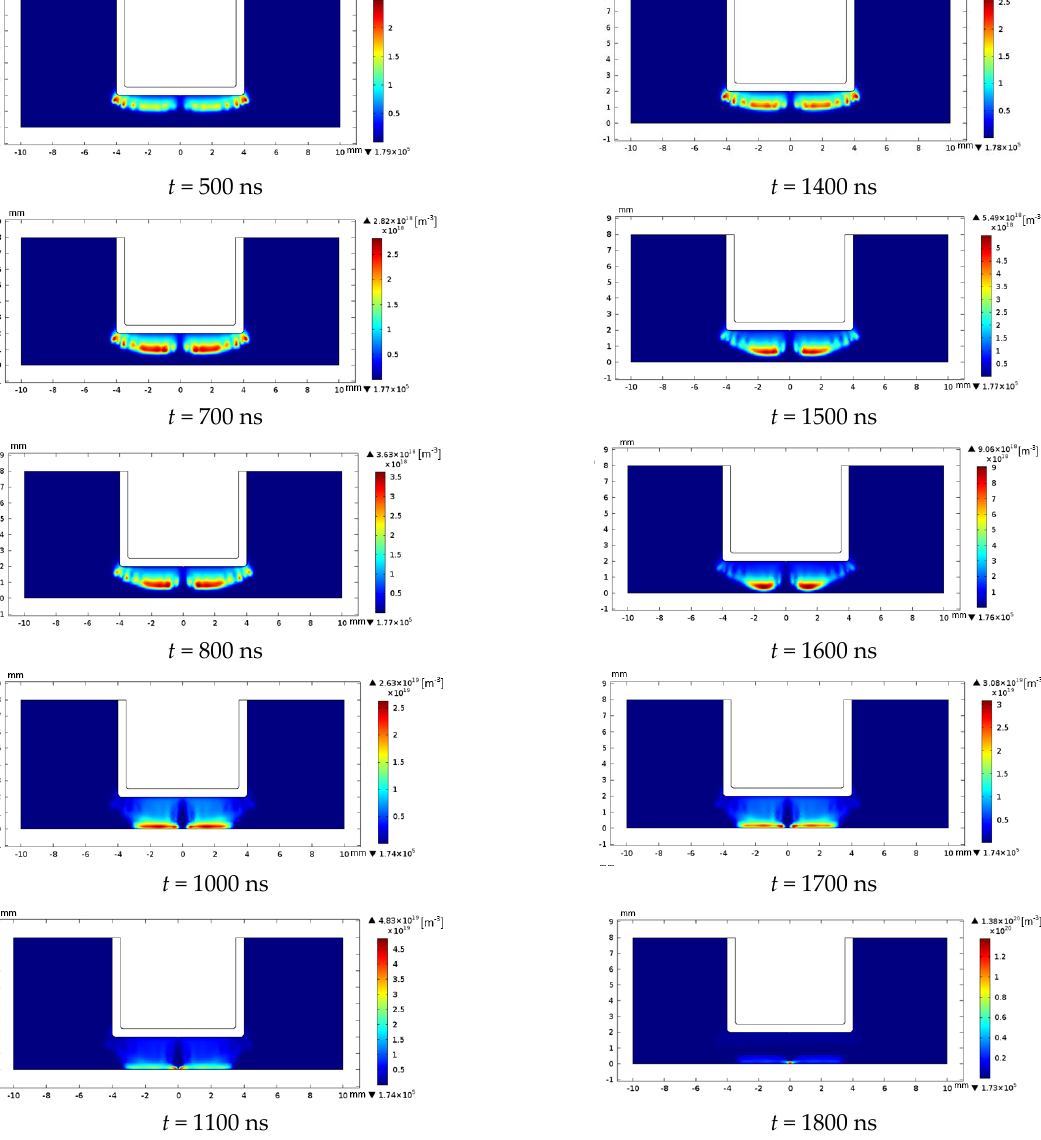
Figure 4. Distribution of electron density between the electrodes of the FE-DBD argon plasma for different instants of pulse discharge supplied at an applied voltage of 10 kV, a frequency of 10 kHz, and pulse duration 1 µs: ( a ) voltage rising edge ( t = 225 ns, 250 ns, 305 ns, 400 ns, 500 ns, 700 ns, 800 ns, 1000 ns, and 1100 ns) and ( b ) voltage falling edge ( t = 1280